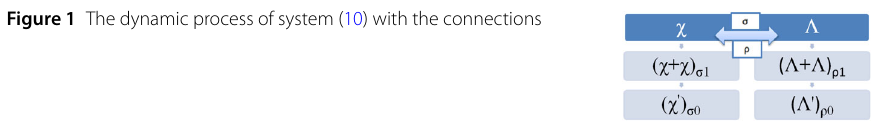
Figure 1 The dynamic process of system (10) with the